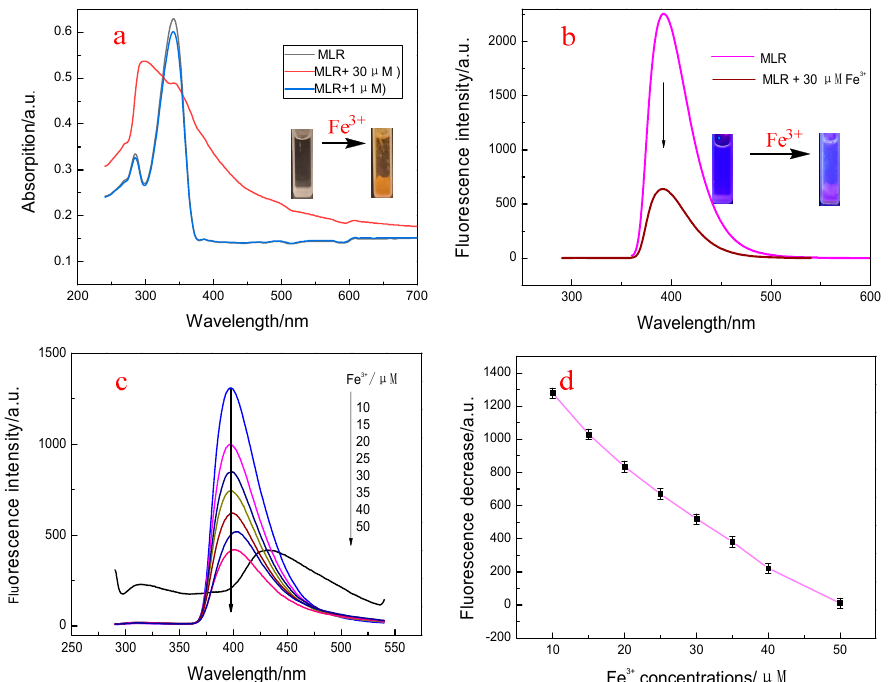
Figure 3. Absorption and fluorescence spectra of MLR with the addition of Fe 3+ . ( a ): Absorption spectrum of MLR in the DMF − HEPES mixed system (3/7, v / v ) upon the addition of Fe 3+ ; ( b ): Fluo- rescence spectra of MLR in the same DMF − water system upon the addition of Fe 3+ ; ( c ): Fluorescence spectra of MLR with the addition of different Fe 3+ concentrations; ( d ): linear relationship between Δ F and Fe 3+ concentration (10~50 μ M).